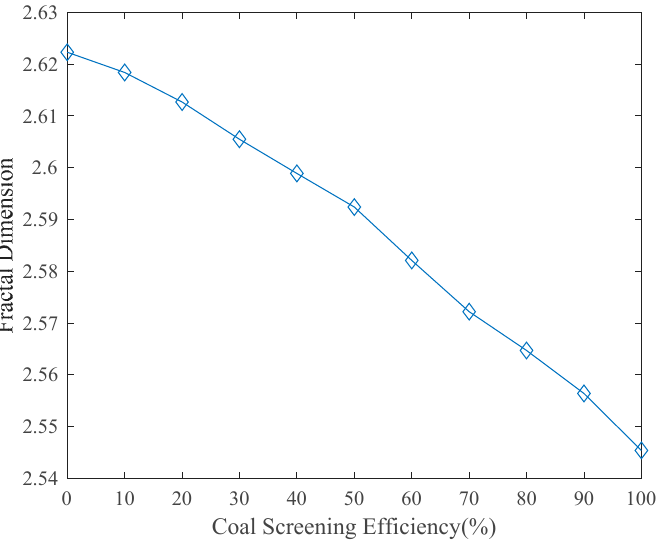
Figure 10. Relation of coal-screening efficiency and fractal dimension for coal-edge images.